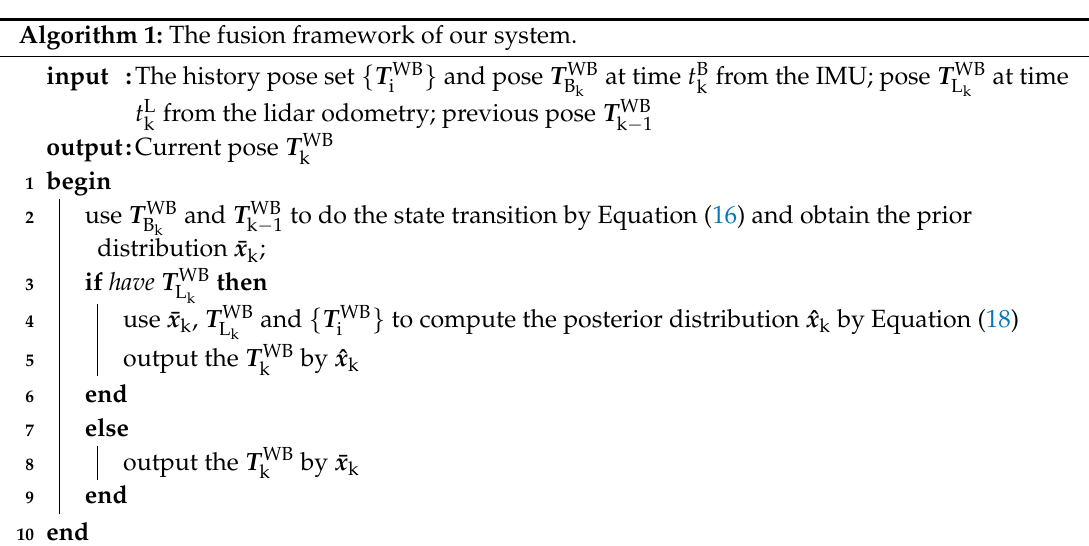
Algorithm 1: The fusion framework of our system.